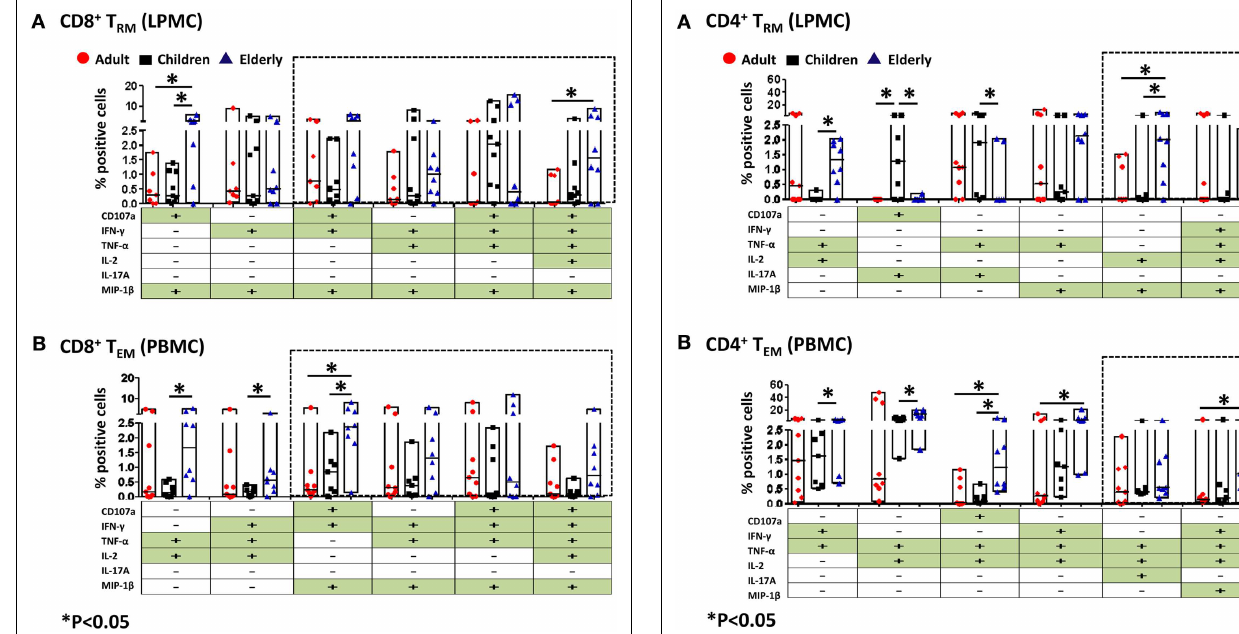
FIGURE 6 | Multifunctional gastric LPMC CD8 + T RM and PBMC CD8 + T EM responses to SEB stimulation in adults, children, and the elderly . Multifunctionality was determined by simultaneous detection of two or more functions performed by CD8 + T RM (LPMC) or CD8 + T EM (PBMC). Six functions were evaluated: production of five cytokines/chemokines (IFN- γ ,TNF- α , IL-2, IL-17A, MIP-1 β ) and expression of CD107a in response to SEB stimulation. (A) Scatter plot showing the six predominant function patterns in LPMC CD8 + T RM and (B) in PBMC CD8 + T EM cells from adults (red circles, n = 9), children (black squares, n = 7), and the elderly (blue triangles, n = 8). Multifunctionality was analyzed using the FCOM feature ofWinList. Significant differences between age groups were denoted by asterisks (* p < 0.05). Black dotted boxes indicate the same multiple cytokine-producing cells in LPMC and PBMC CD8 + T subsets.